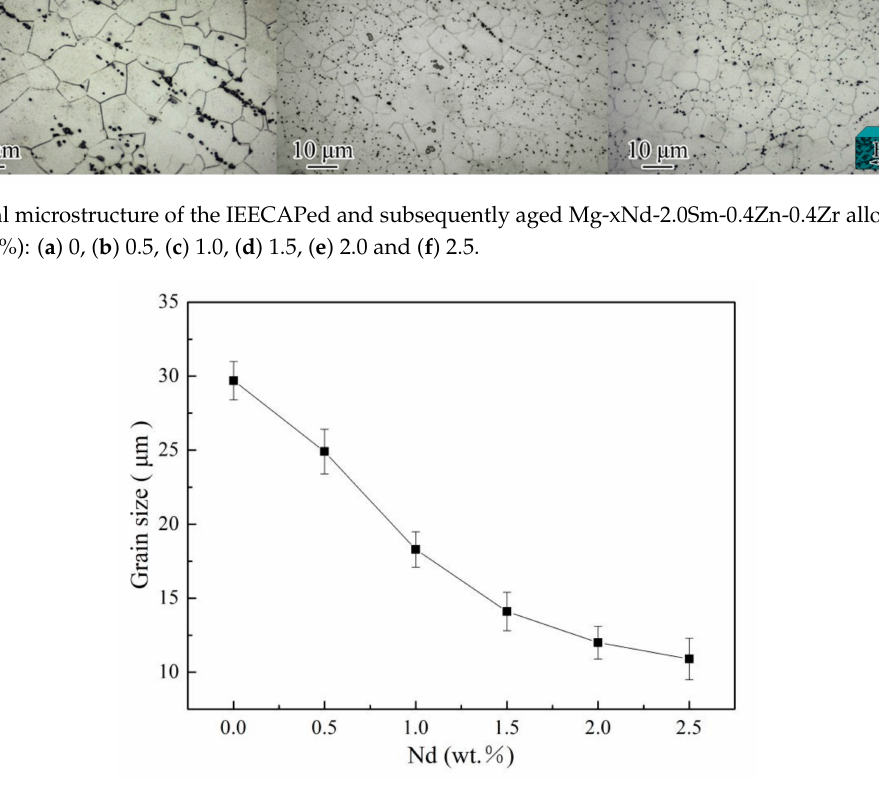
Figure 3. Grain size of the IEECAPed and subsequently aged Mg-xNd-2.0Sm-0.4Zn-0.4Zr alloys by Nd